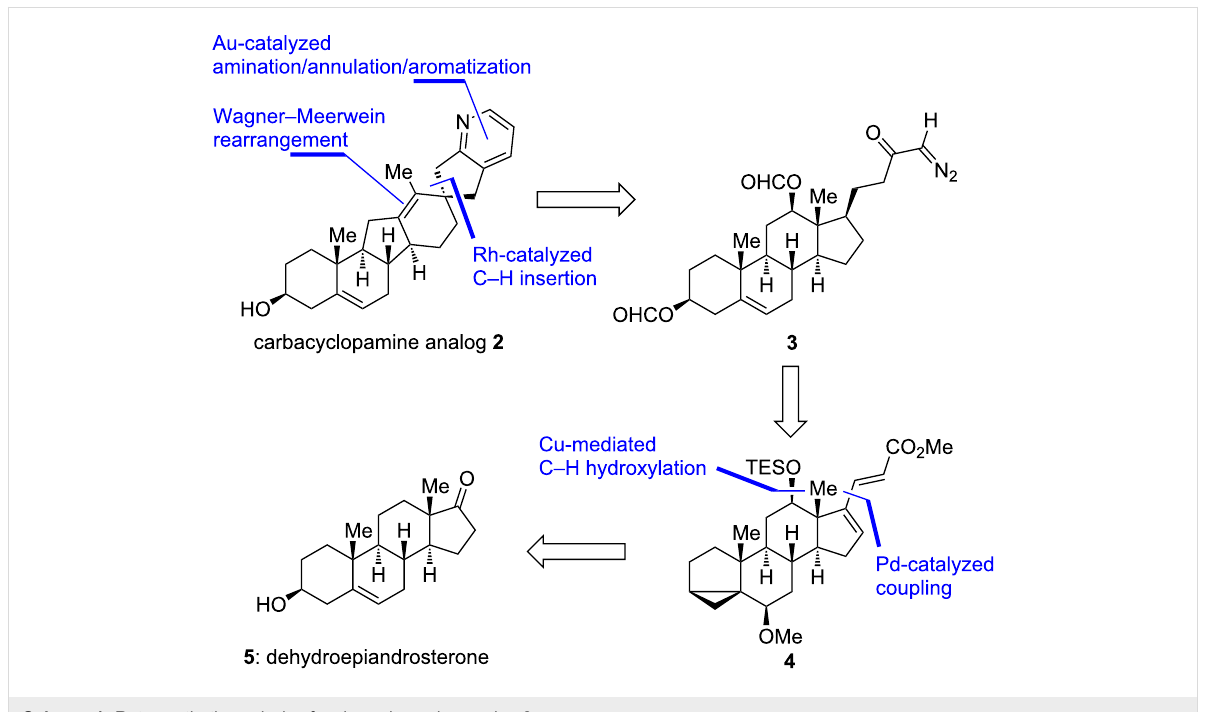
Scheme 1: Retrosynthetic analysis of carbacyclopamine analog 2 .